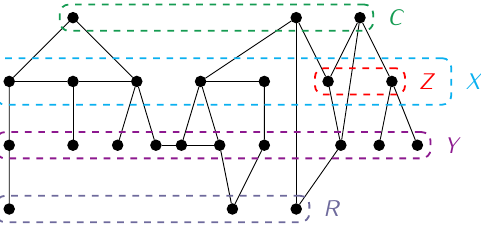
Figure 1. A graph